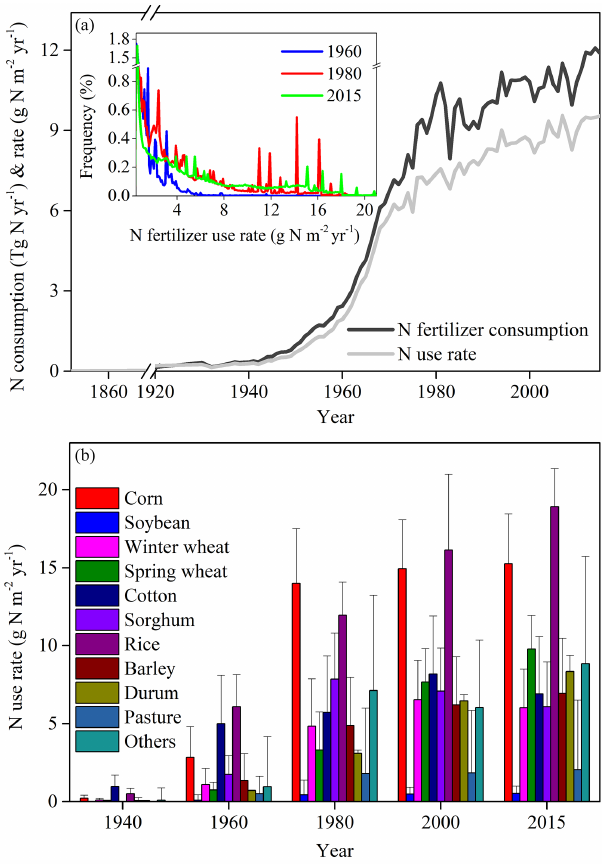
Figure 2. Time series of N fertilizer use in the US: (a) national commercial N fertilizer consumption and use rate of the contiguous US from 1850 to 2015 derived from this study (figure inset pro- vides the N fertilizer rate distribution across the contiguous US in the years 1960, 1980, and 2015); (b) national crop-specific N fertil- izer application rate (error bars indicate standard error among states in 1